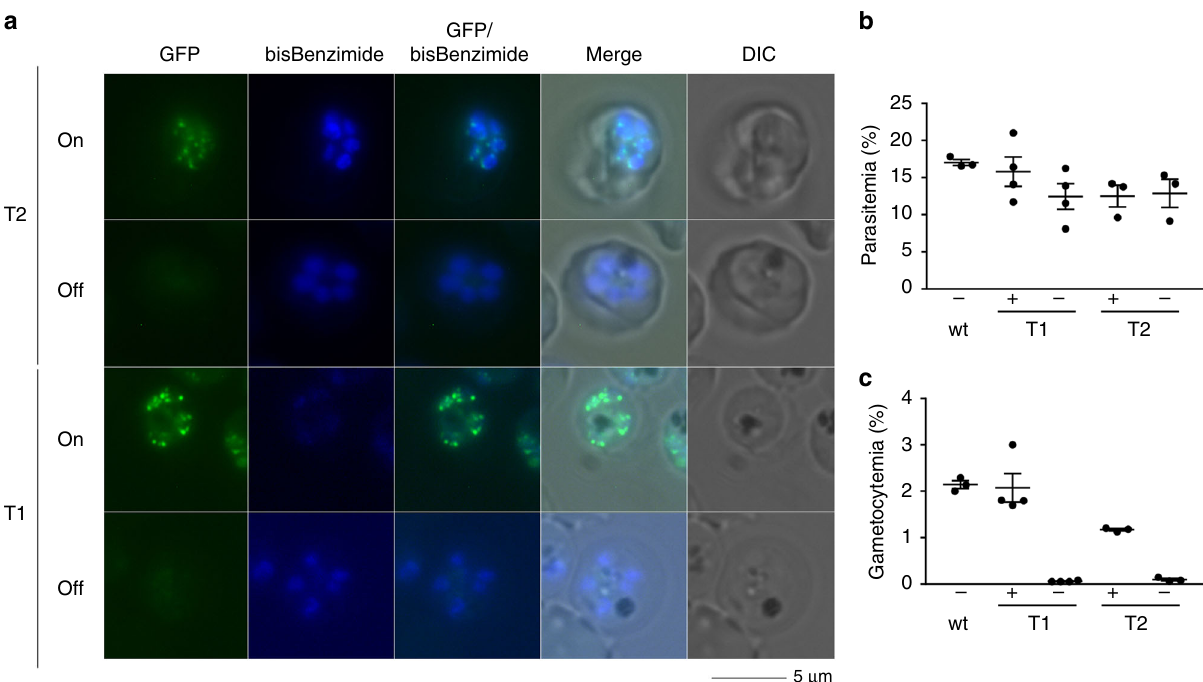
Fig. 5 Shld1-dependent GDV1-GFP expression and gametocyte production in Pfgdv1.gfp.dd parasites. a Representative fl uorescence microscopy images of un fi xed Pfgdv1.gfp.dd .T1 and T2 parasites cultured in the presence (On) or absence (Off) of 500 nM Shld1. Pfgdv1.gfp.dd parasites were re-suspended in PBS containing bisbenzimide (5 µ g/ml) and visualized using a Zeiss Axiovert 200 fl uorescence microscope at ×1000 magni fi cation using AxioVision v4.3.0 101 software. b , c Shld1-dependent Pfgdv1.gfp.dd gametocyte production. Parental NF54 (wt) and Pfgdv1.gfp.dd clones T1 and T2 were set up at